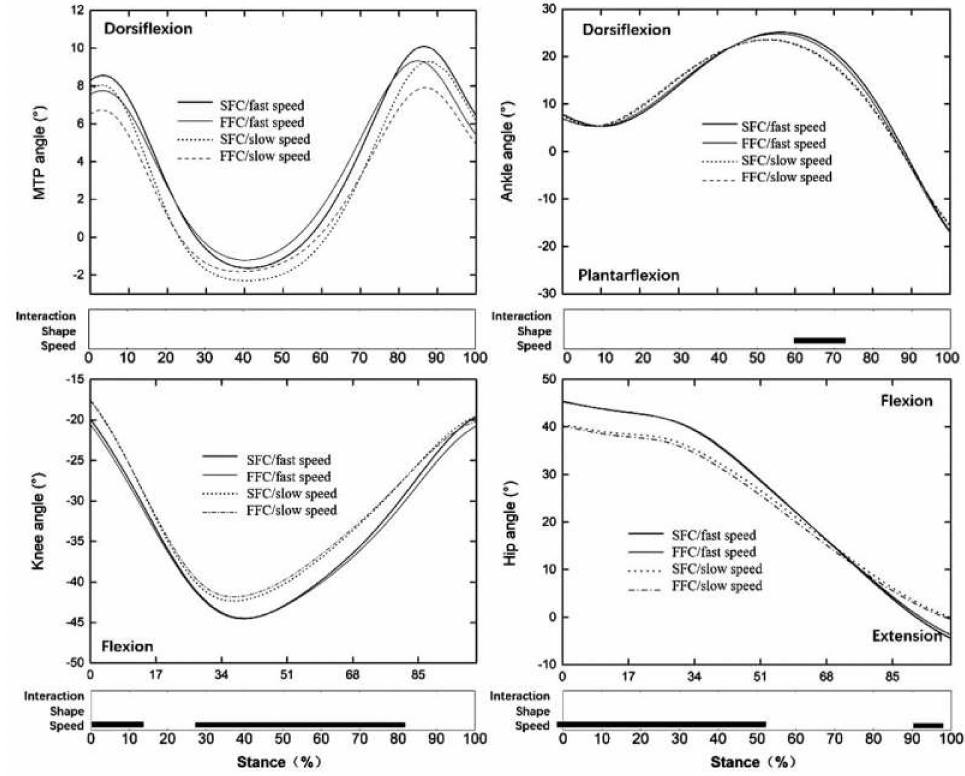
Figure 5. Lower limb joint angles time −